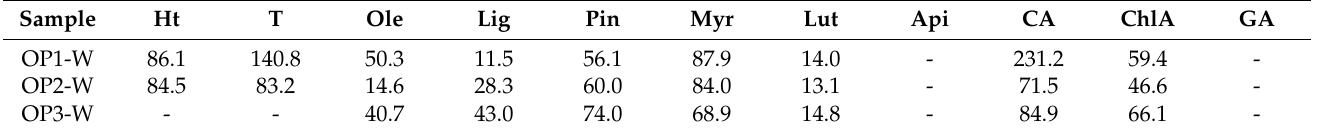
Table 3. Bioaccessibility index (%) of metabolites in the absorbable aqueous-digested OP samples (OP-W). See Table 1 for